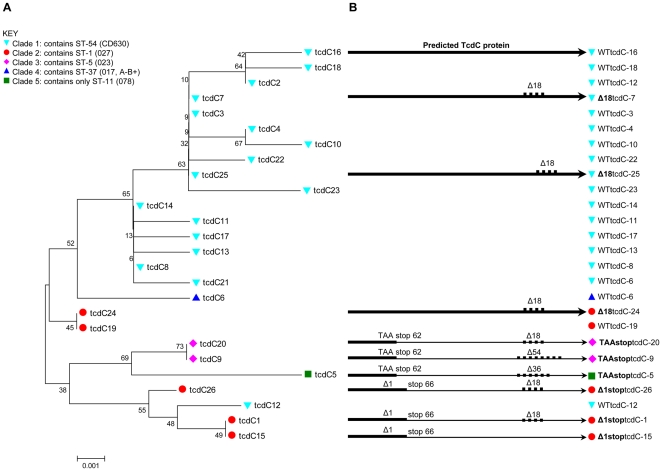
The association of tcdC alleles and clade is almost congruent.(A) Neighbour joining tree showing the relationship among tcdC variants and the clades. The variants were manually aligned in BioEdit and a neighbour joining tree was computed using MEGA with bootstraps calculated using 1000 replicates. Coloured shapes indicate the clade (Fig. 1) with which the tcdC allele was associated. Alleles appear the same if they differ only in terms of their relative deletion lengths which are indicated in (B). Alleles WTtcdC-8 and WTtcdC-14 appear the same on the tree as they differ by a single nucleotide at position 117, which is deleted in some other alleles and therefore contained an N in some variants in the alignment. (B) Predicted translation products from tcdC variants. Three different TcdC variants were found (i) wild type (WT) (ii) truncated by Δ1 at nucleotide 117 creating a frameshift and a stop codon at amino acid 66, (Δ1stop), or by a CAA to TAA substitution creating a stop codon at amino acid 62, (TAAstop) (iii) 18 nucleotides deleted (Δ18) within the coiled-coil dimerization domain. Further deletions within the untranslated sequence of clade 3 and clade 5 were 36 nucleotides long (Δ36) or 54 nucleotides long (Δ54). Translated regions are represented in the figure by the bold black line; untranslated regions are represented by the light black line.